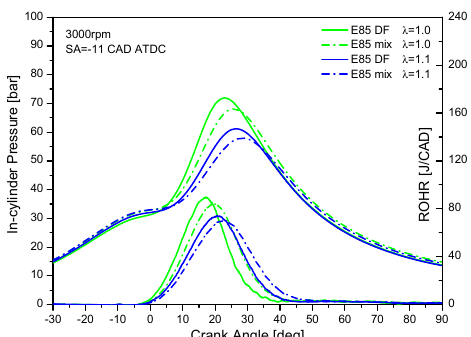
Figure 5. In-cylinder pressure and rate of heat release in Cyl. #2 for E85 at λ = 1 and 1.1 at SA = − 11 CAD ATDC.